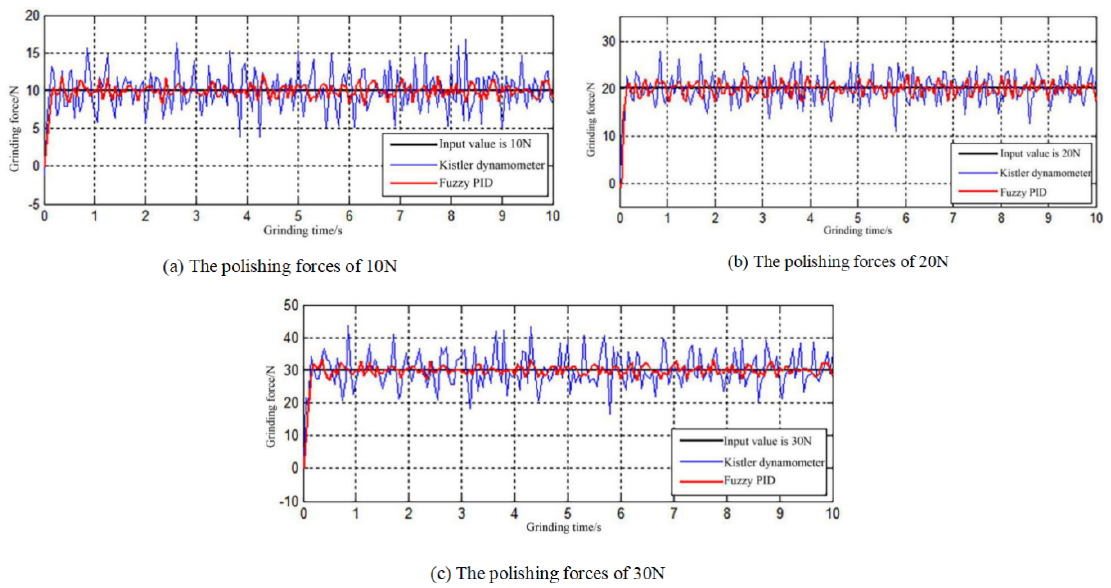
Figure 14. Comparison between actual measurement data and fuzzy PID.